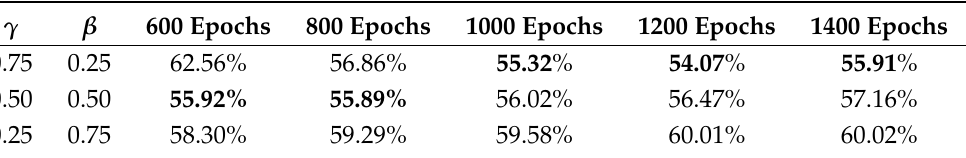
Table 2. Experimental results of RTVE 2020 Multimodal Diarization test set, showing DER%. These results were obtained by sweeping of the parameters of aDCF loss function and by different number of training epochs. The best results are marked in bold.